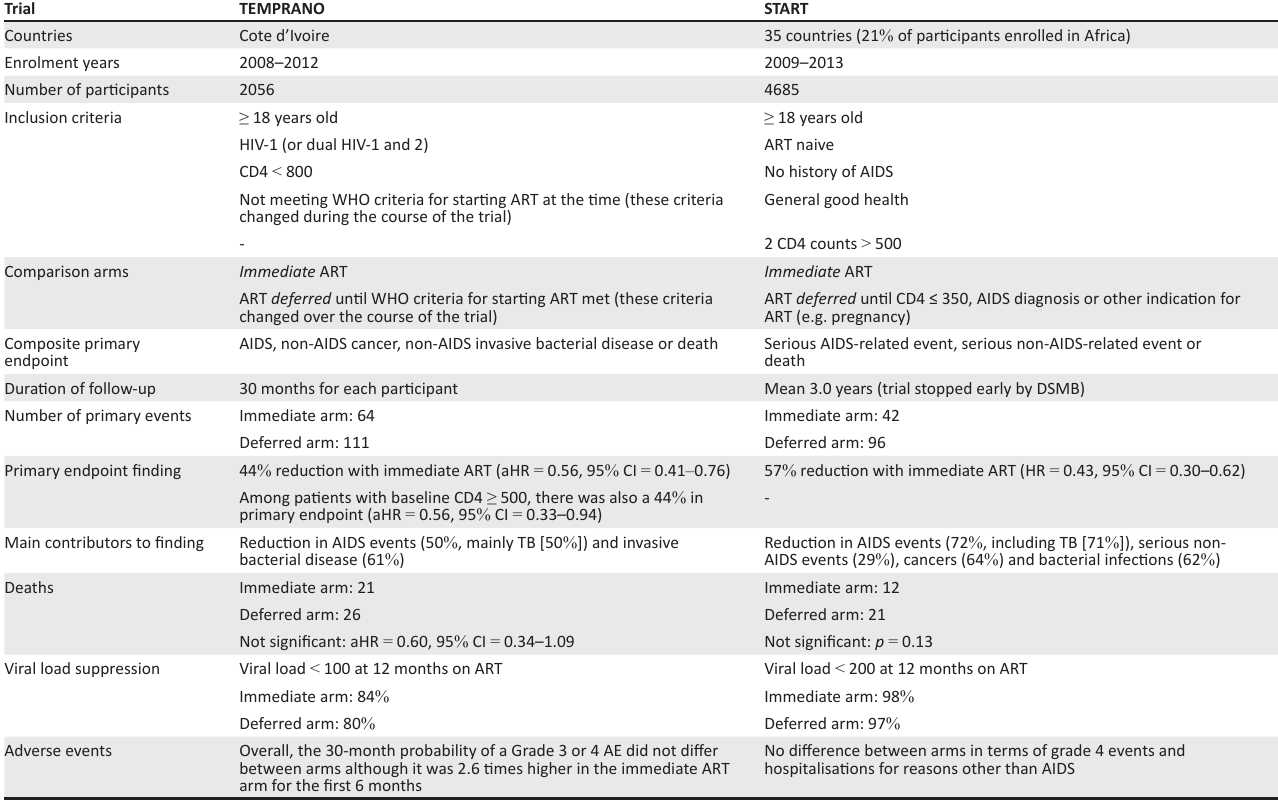
TABLE 1: Summary of design, conduct and findings of the Strategic timing of antiretroviral therapy and TEMPRANO ANRS 12136 (Early antiretroviral treatment and/or early isoniazid prophylaxis against tuberculosis in HIV-infected adults) randomised controlled trials. Trial TEMPRANO START Countries Cote d’Ivoire Enrolment